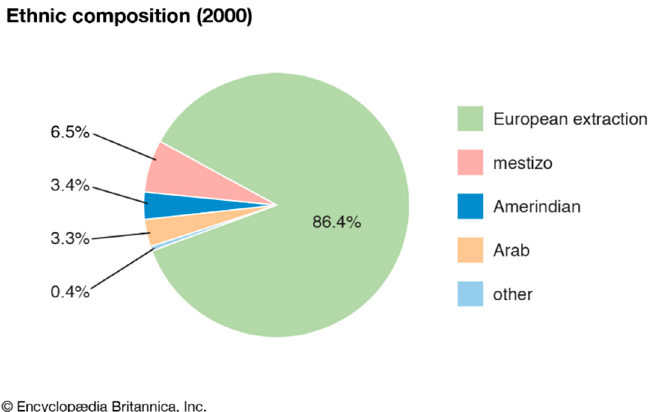
Figure 1. Ethnic composition in Argentina. [10].